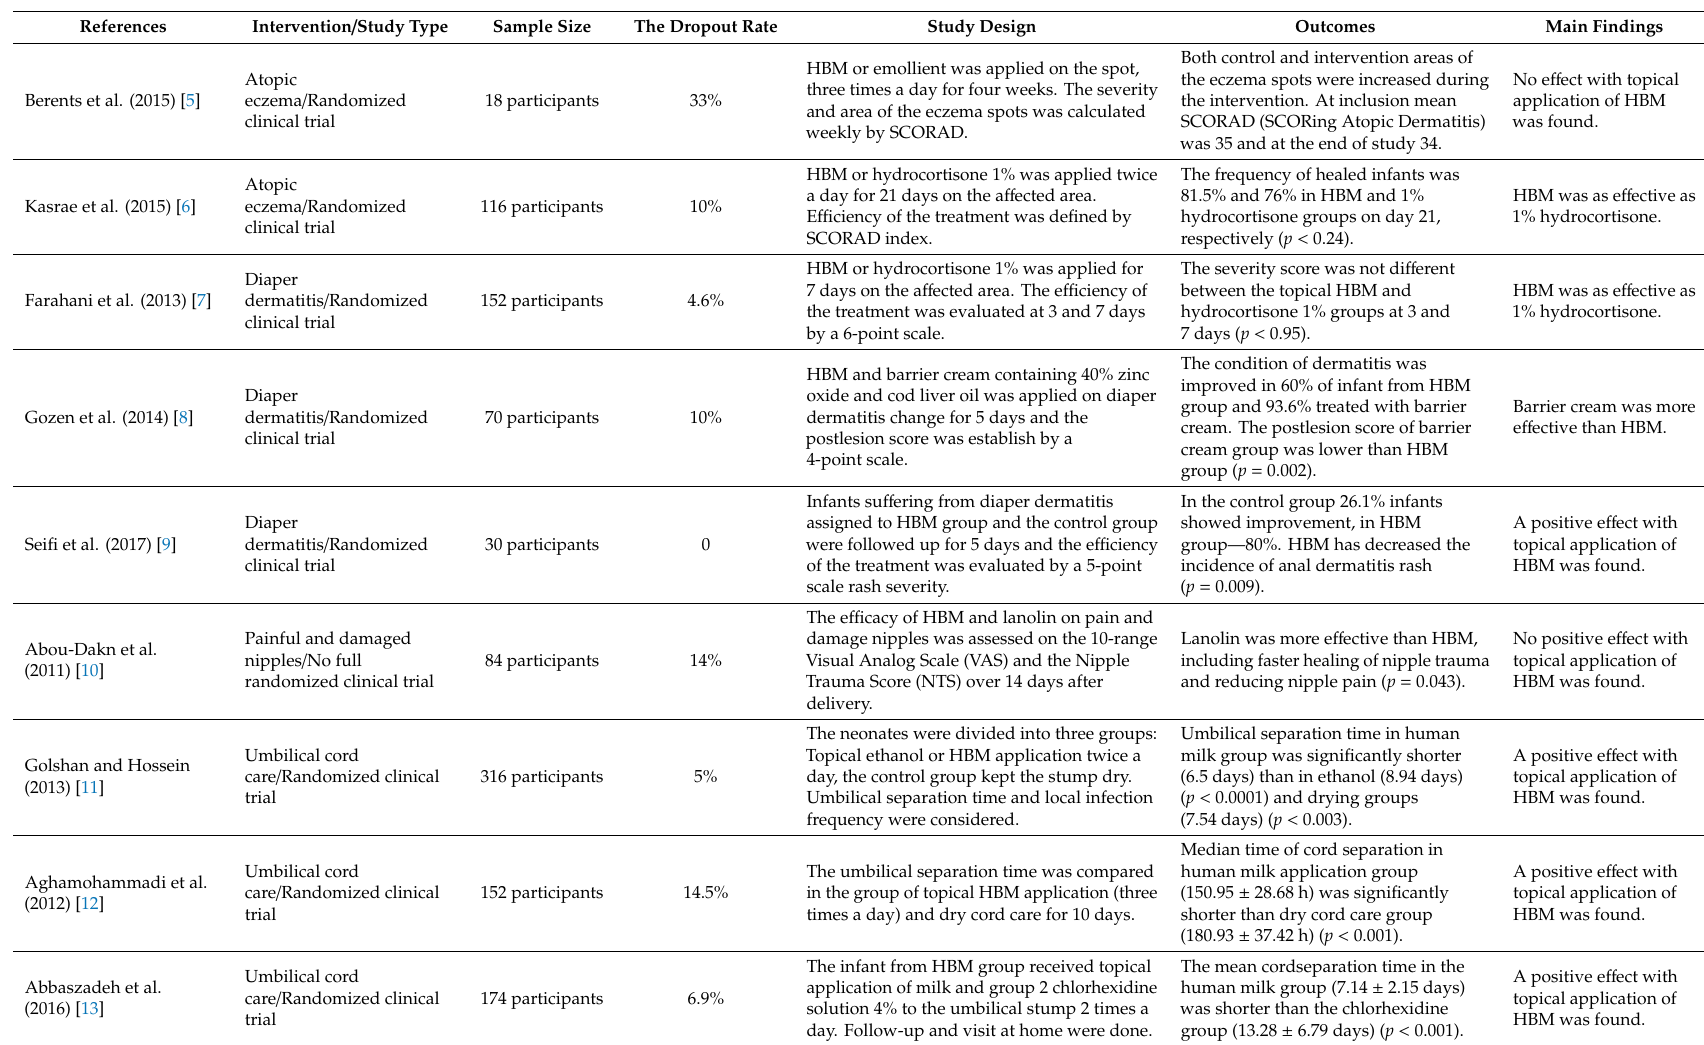
Table 1. Articles included in this review, with study